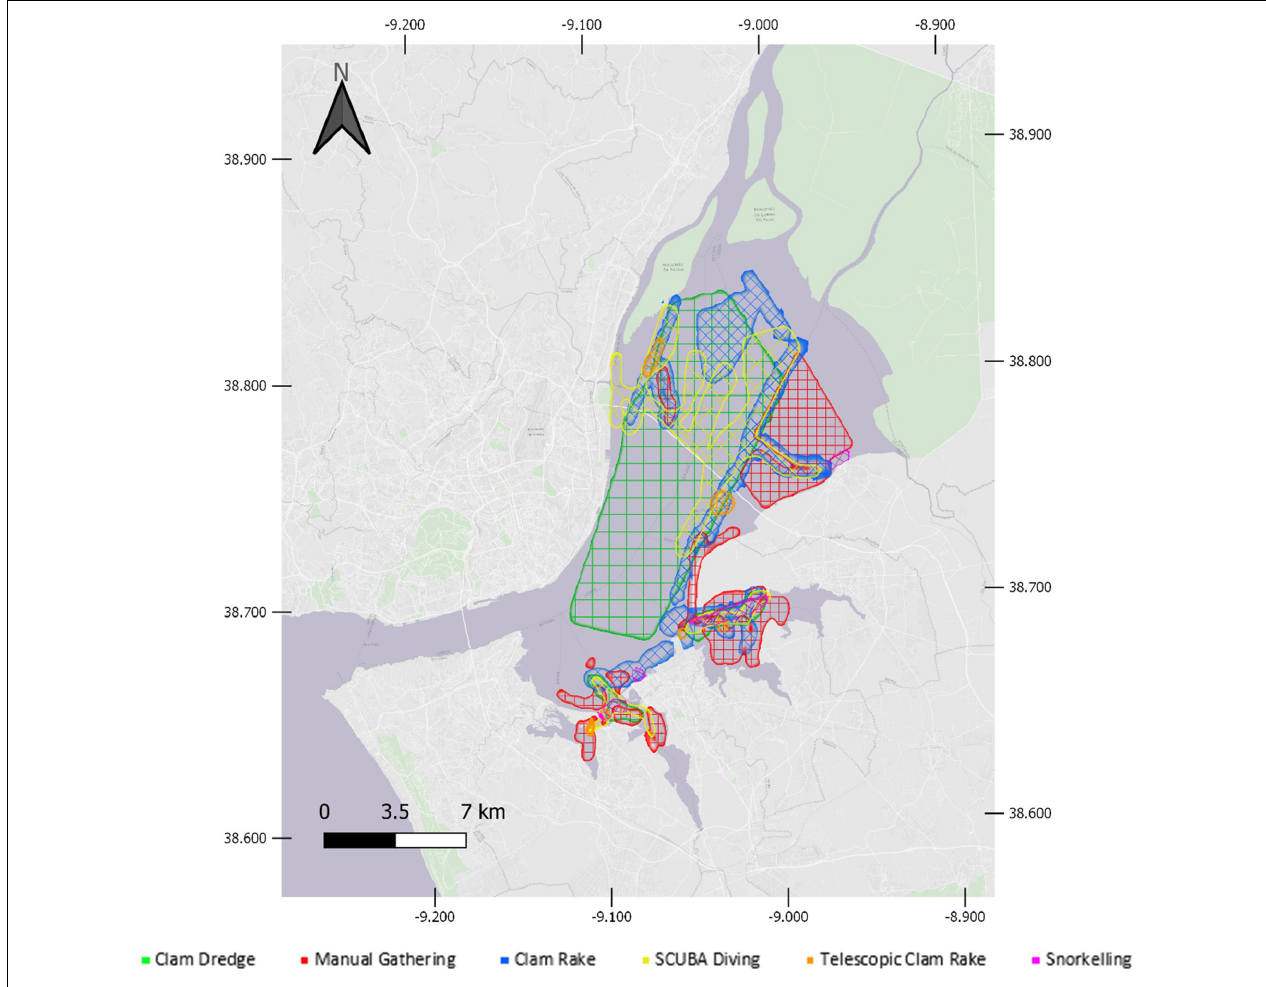
FIGURE 4 | Zonation of Manila clam harvesting techniques used in the Tagus (Source: Ramajal et al.,